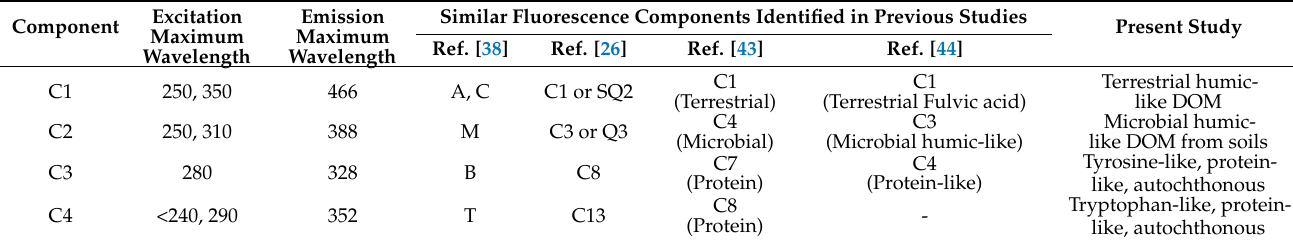
Table 3. Characteristics of the four fluorescence components identified by EEM-PRAFAC (DrEEM toolbox) and the attributed sources in Mayfield Creek, the southeastern United